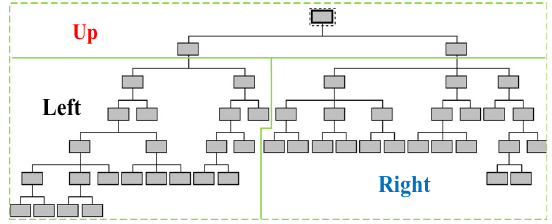
Fig. 2 A tree diagram. A tree diagram for the training/test sample.